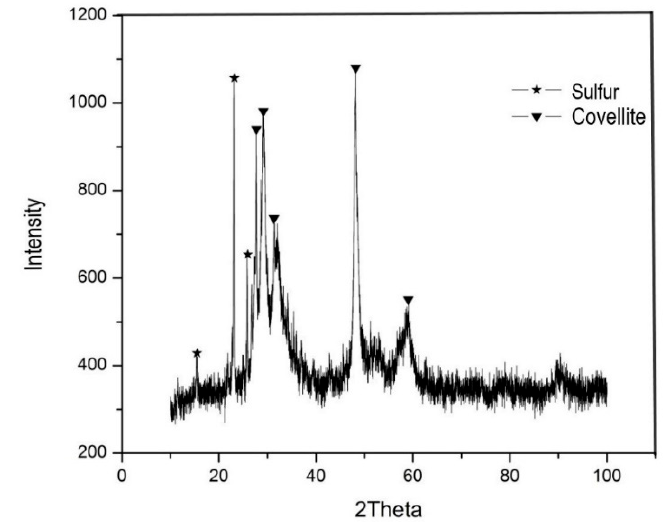
Figure 9. Residue diffractogram after 4 days of leaching with 4 g/L of Fe3+, 20 g/L H 2 SO 4 , and 30 g/L NaCl in conditions of 1 atm, 22 °C and 400 rpm.